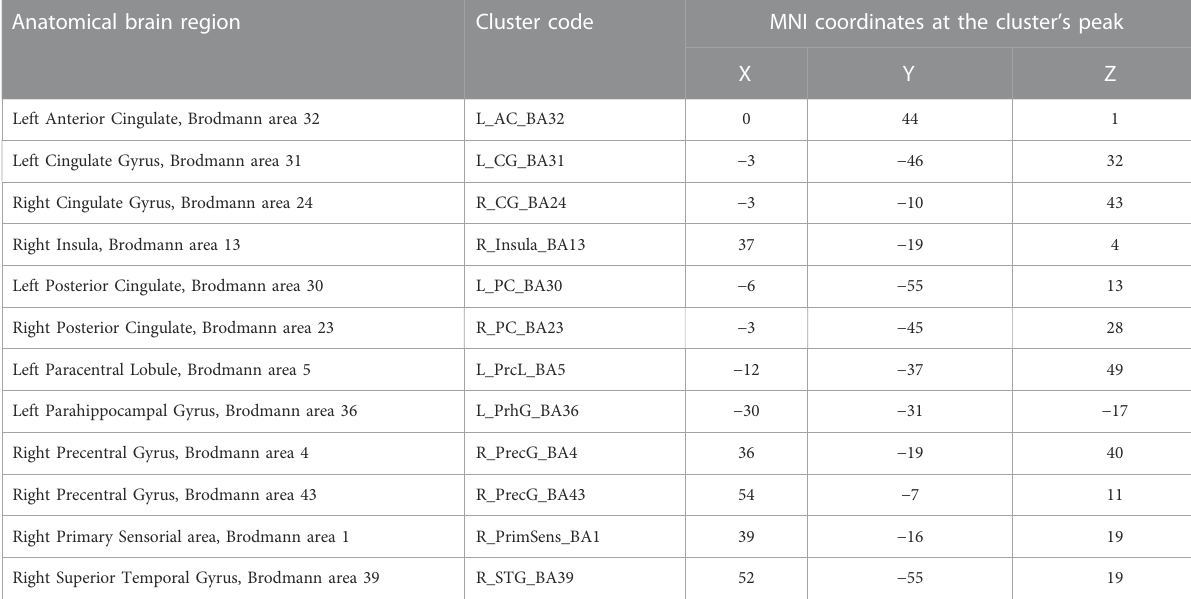
TABLE 3 Clusters with negative signal change during stimulation blocks. Anatomical brain